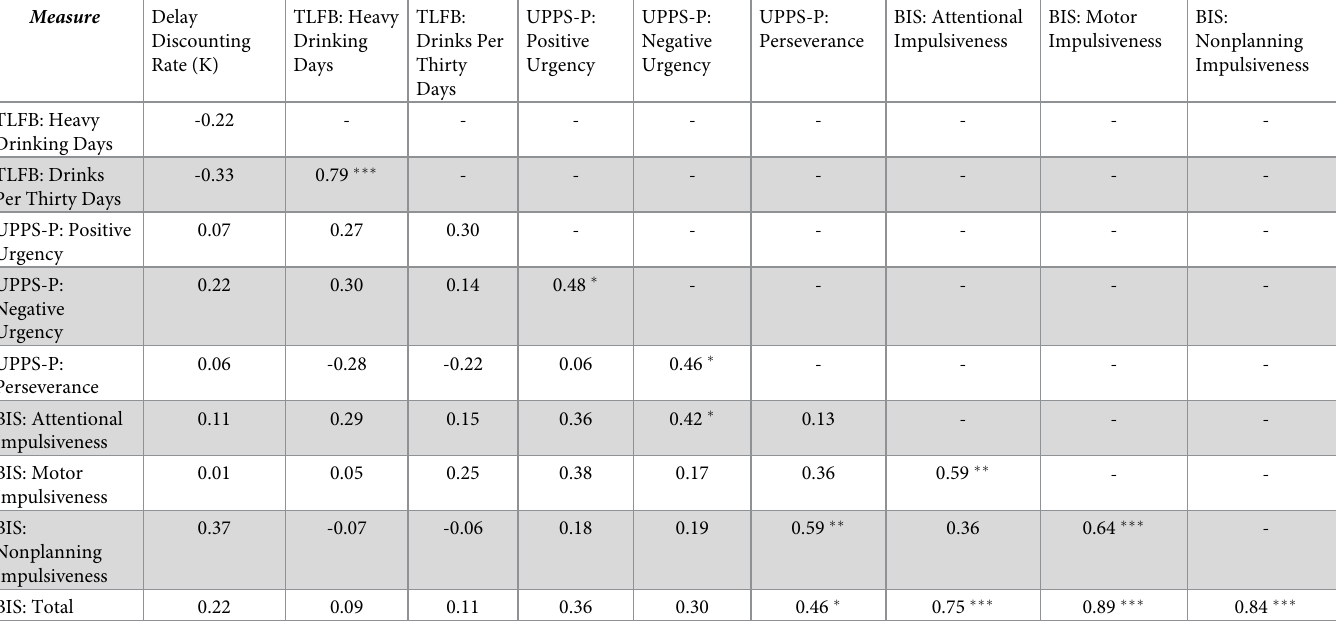
Table 2. Correlations between drinking and impulsivity measures. Measure Delay Discounting